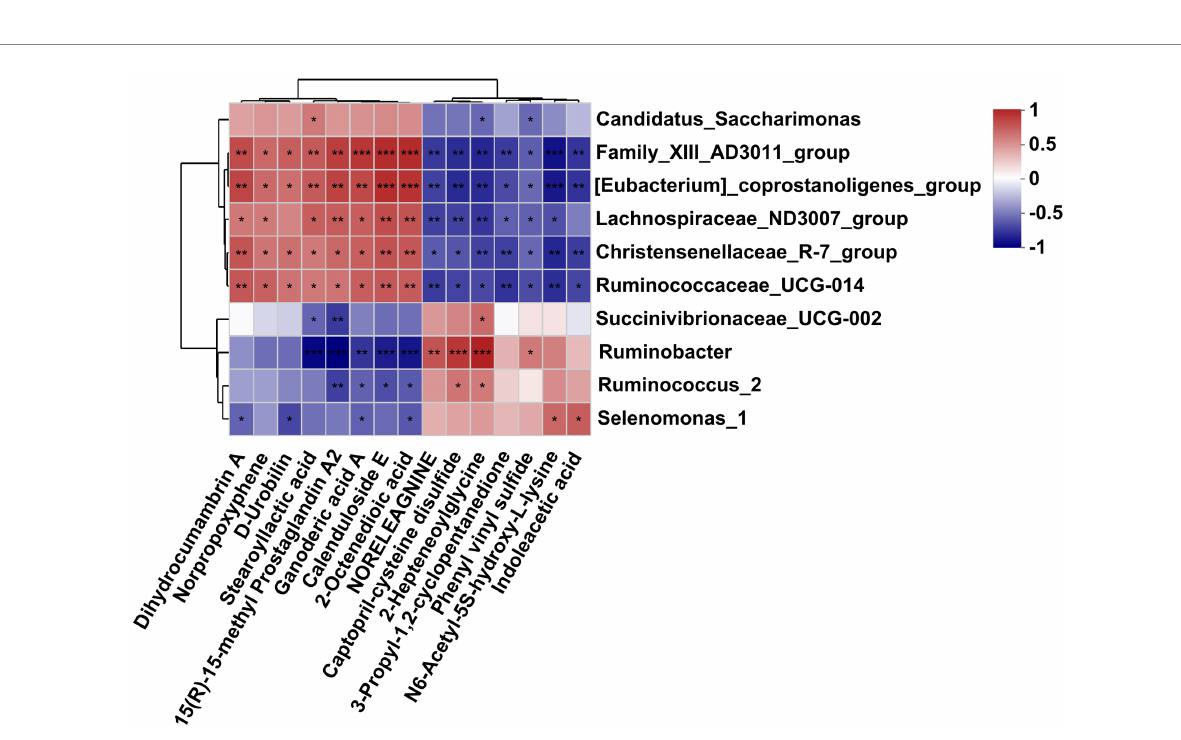
FIGURE 6 Correlation analysis of differential bacteria genus and differential metabolites in the rumen fluid of dairy cows after 48 h in vitro fermentation with two glucogenic and a lipogenic diet. Each row represents a bacteria genus, only the genera with relative abundance >0.5% are selected; each column represents a metabolite, only the affected metabolites with VIP > 1.5, FC < 0.5 and > 2 are considered. The color blue means negative correlation, the color red means positive correlation. *0.01 < p ≤ 0.05, **0.001 < p ≤ 0.01, *** p ≤